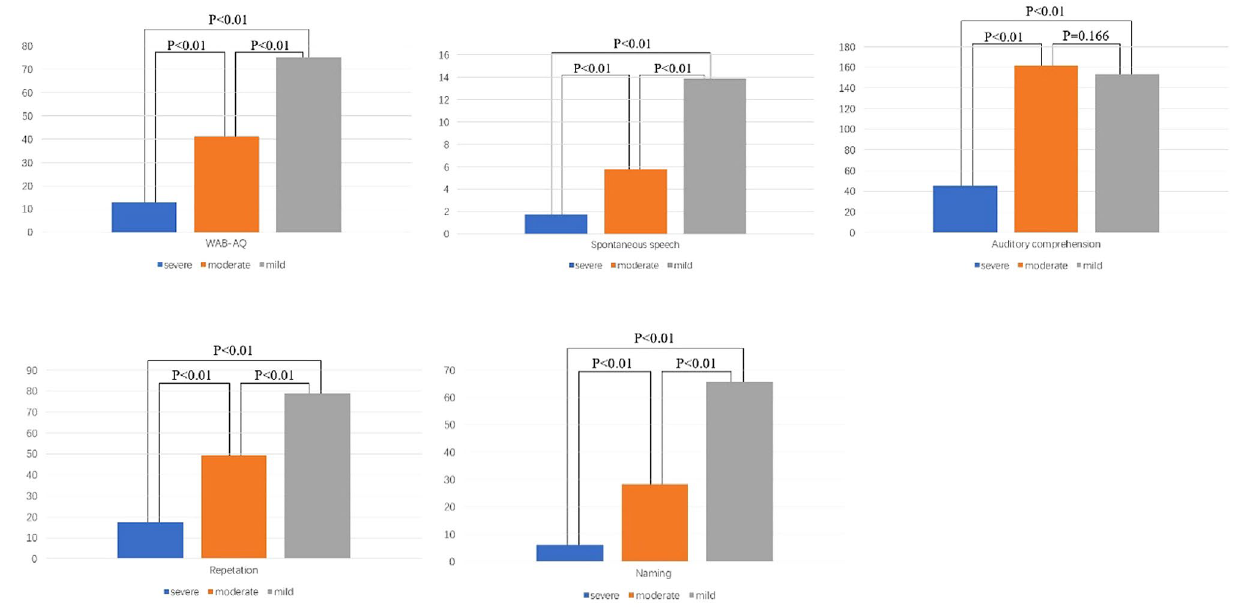
Figure 1. The characteristics of linguistic deficit within each cluster were defined by the aggregate scores of the WAB-AQ sub-tests. The mean subtest scores of each group were compared between